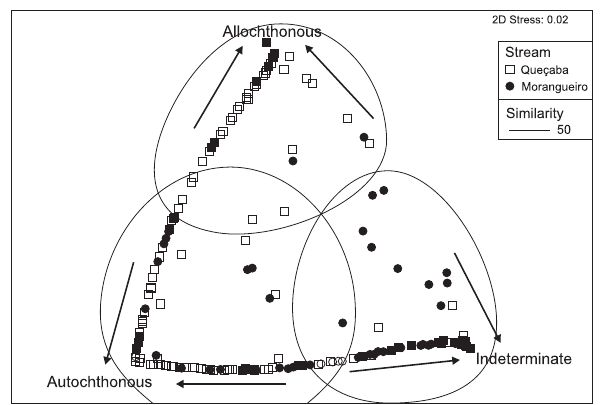
Figure 5. Two-dimensional plot of the NMDS analysis using the volume values grouped according to origin with symbols repre- senting the factor “stream”, which had an influence on cluster formation, as confirmed by ANOSIM (Global R = 0.105 and p = 0.001) and with overlapping clusters (circles) delimiting groups. The arrows indicate the direction of increase for the contribution of food items in the